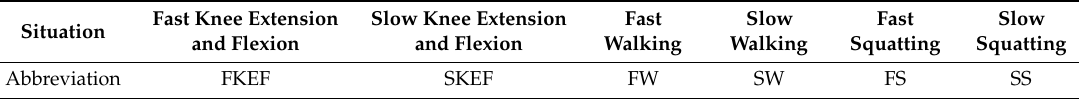
Table 2. Six experimental situations and abbreviations.